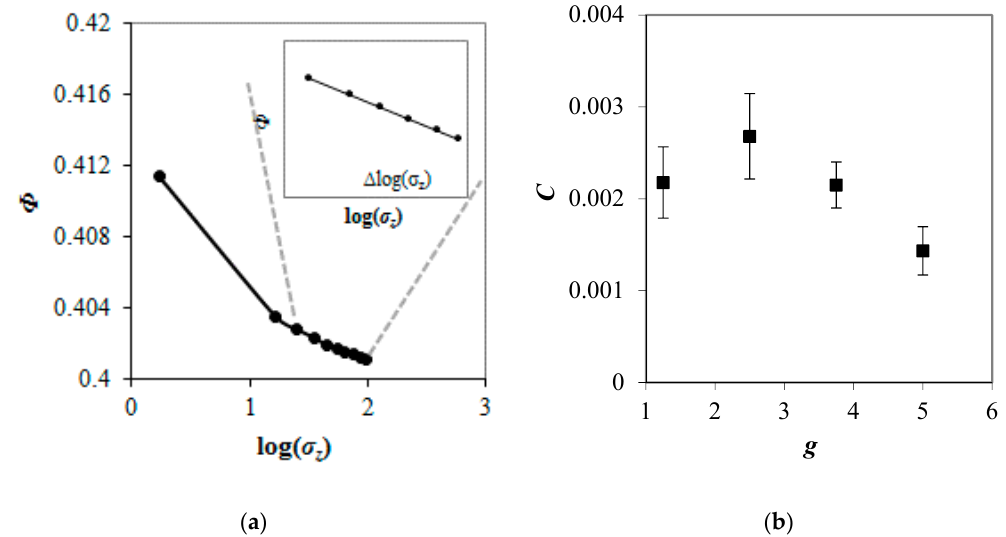
Figure 3. Relationship between the porosity and logarithm of vertical load for mixture with g = 2.5 ( a ) and evolution of compression index with particle size ratio in ternary mixtures under vertical load of 100 kPa; ( b ). Inset: zoom into the linear part of Φ (log( σ z )) curve.